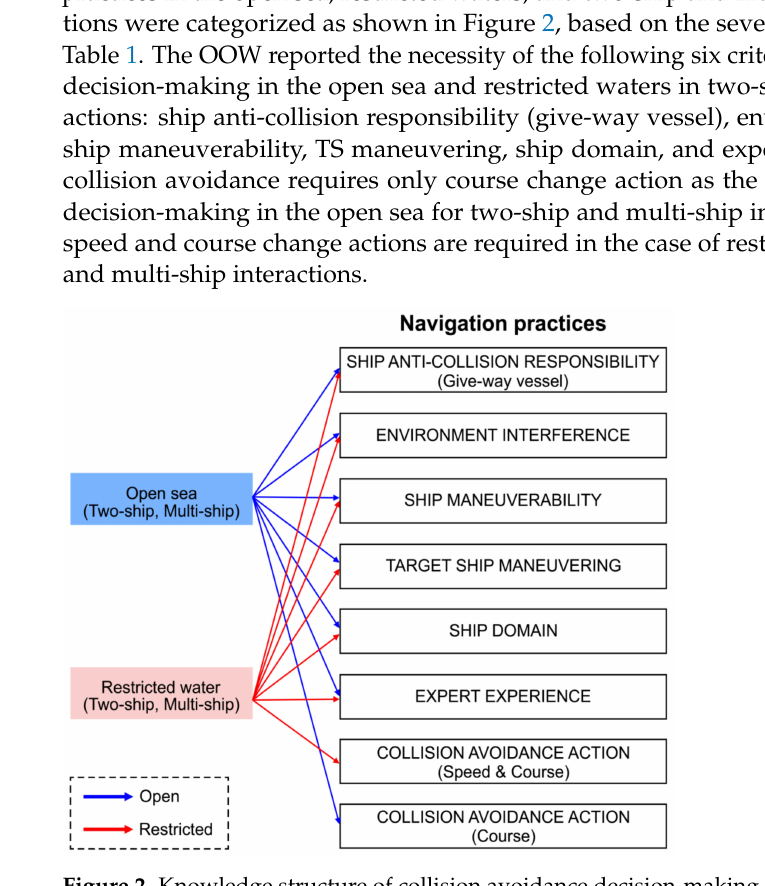
Figure 2. Knowledge structure of collision avoidance decision-making in navigation